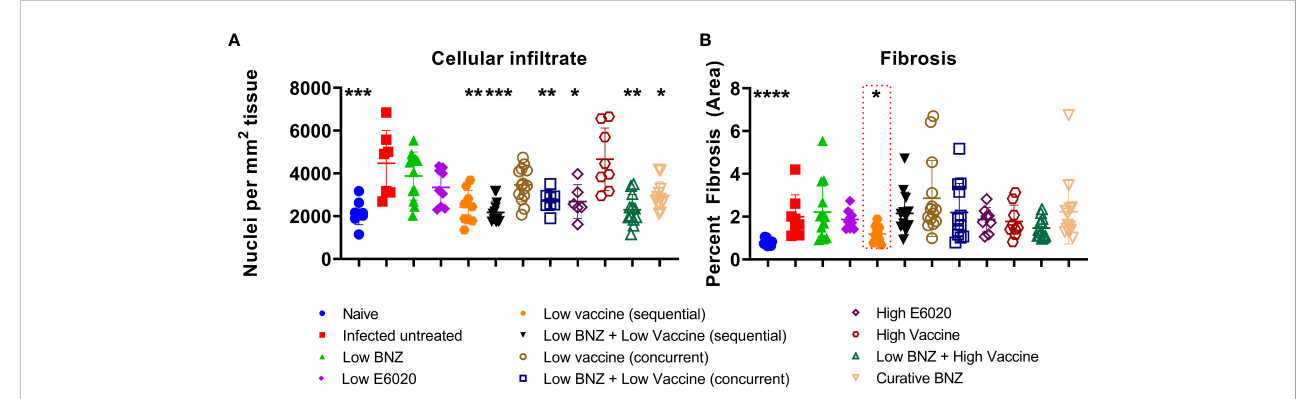
FIGURE 9 Cardiac Cellular in fi ltrate and fi brosis. Cardiac cellular in fi ltrate (A) was quanti fi ed from representative images of H&E stained tissue sections as described. Fibrosis (B) was quanti fi ed from representative images of Masson ’ s Trichrome stained tissue sections as described. When comparing groups to the infected untreated control *, p ≤ 0.05; **, p ≤ 0.01; ***, p ≤ 0.001; ****, p ≤